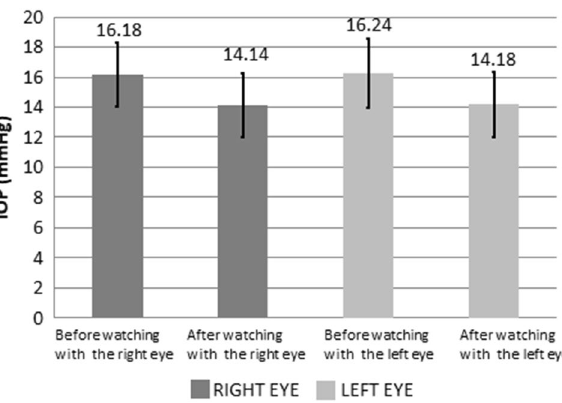
Figure 7. Intraocular pressure changes before and after using VR for watching 3D